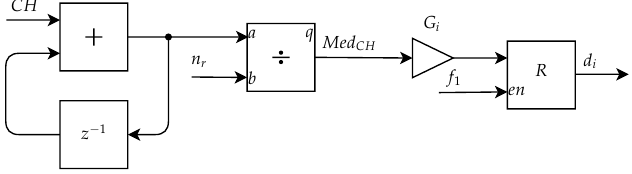
Figure 16. Architecture of the Mean Calculation